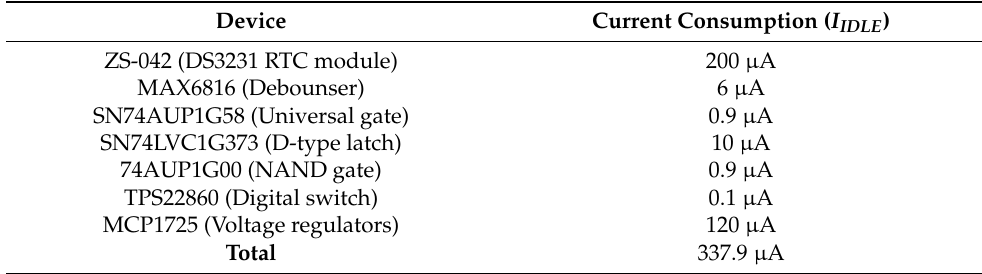
Table 4. Current consumption of SSVM during power-saving